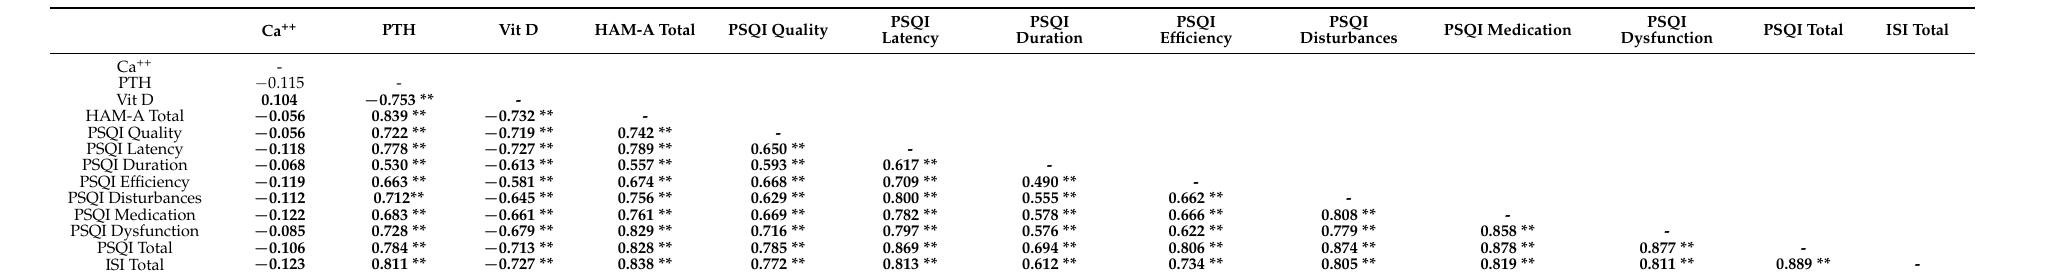
Table 3. Results of Spearman correlation